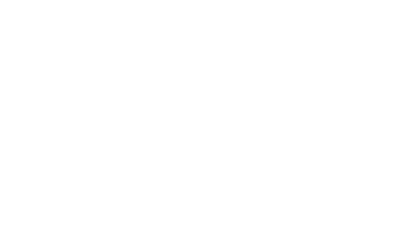
Table 5. Length parameters and